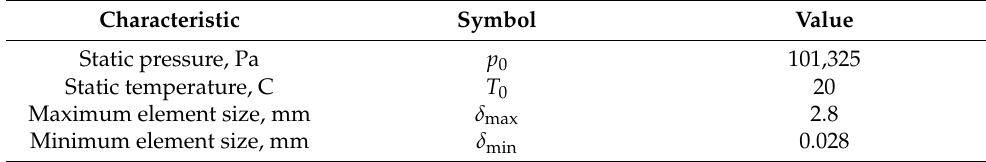
Table 2. Basic parameters of the numerical simulation.